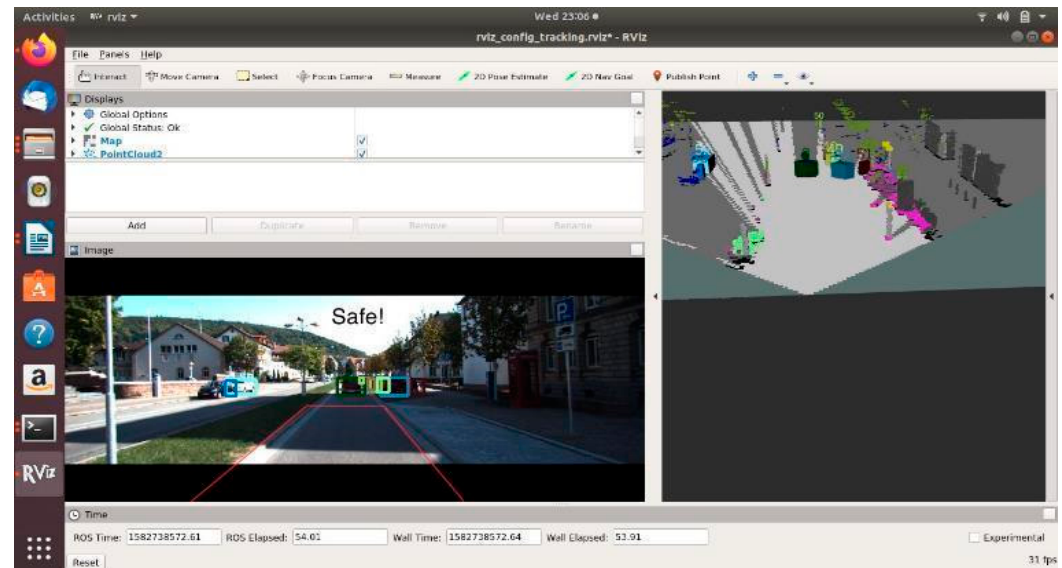
Figure 17. Safe scenario detected by OCSF.